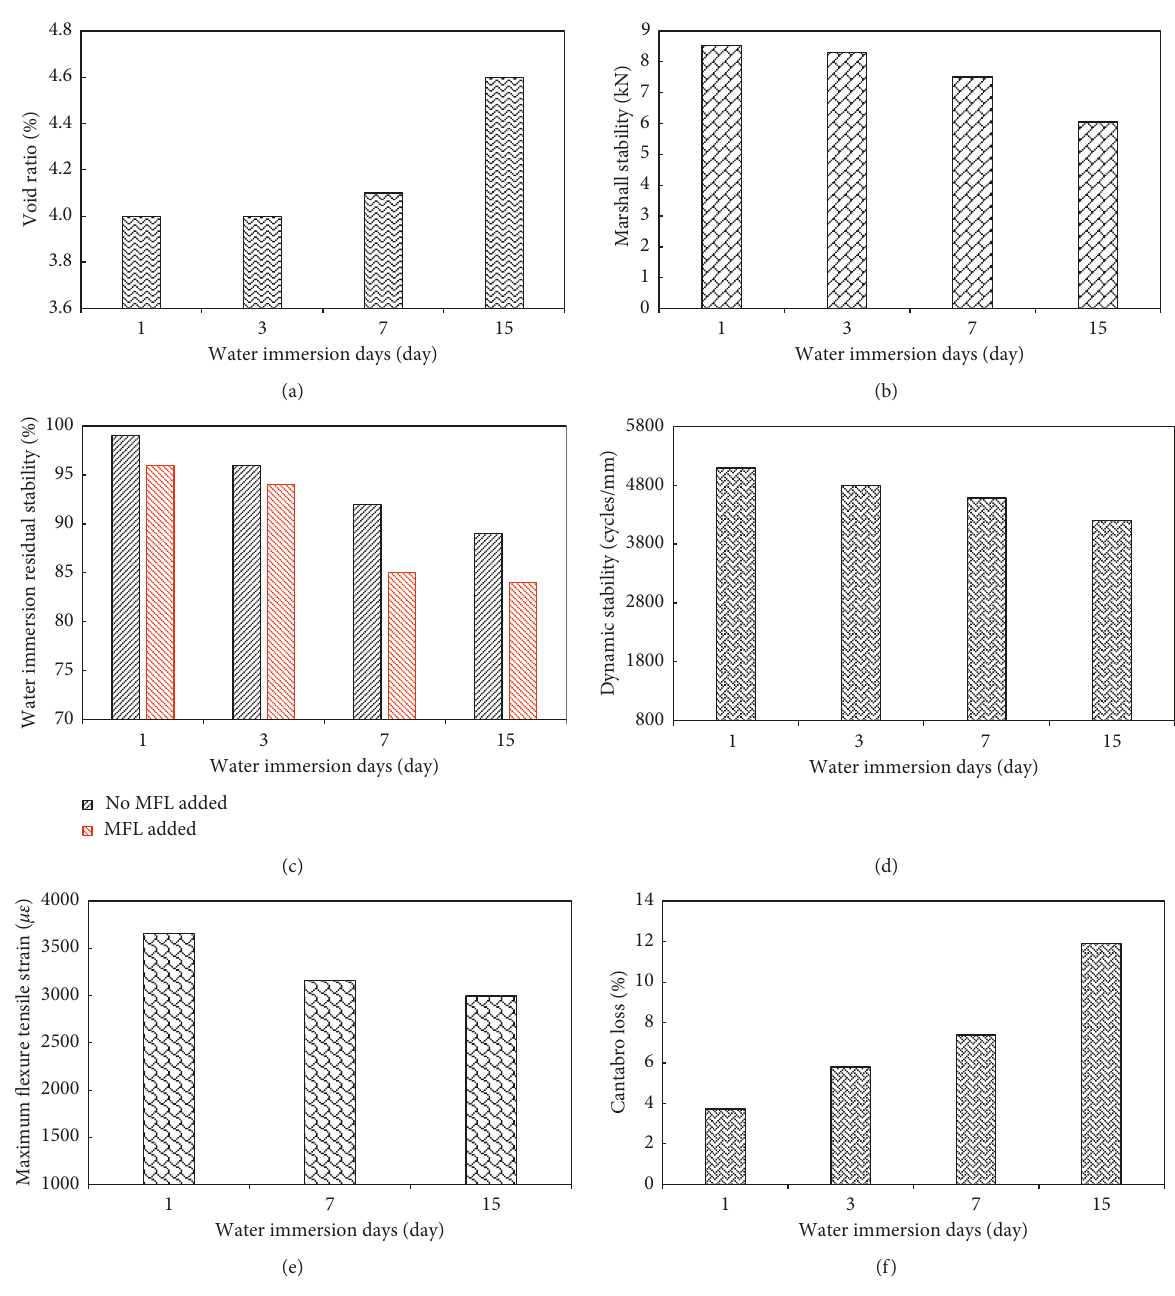
Figure 10: Long-term pavement performance test